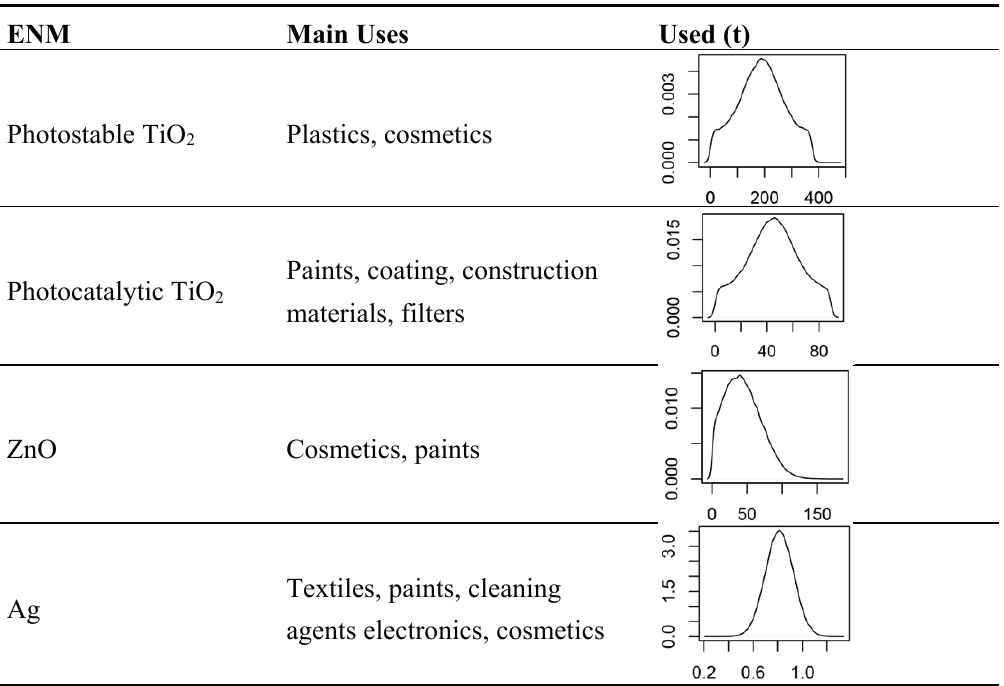
Table 1. Overview about the considered nanomaterials, their main uses and the amount used per year in Denmark. The curves represent probability distributions in the form of probability density